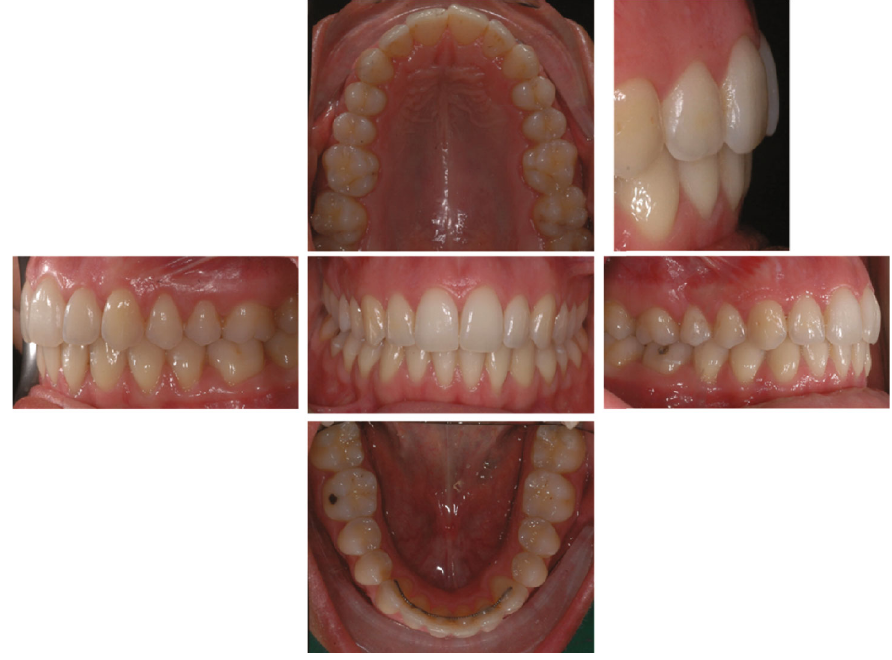
Figure 20: 14-year follow-up intraoral photographs.